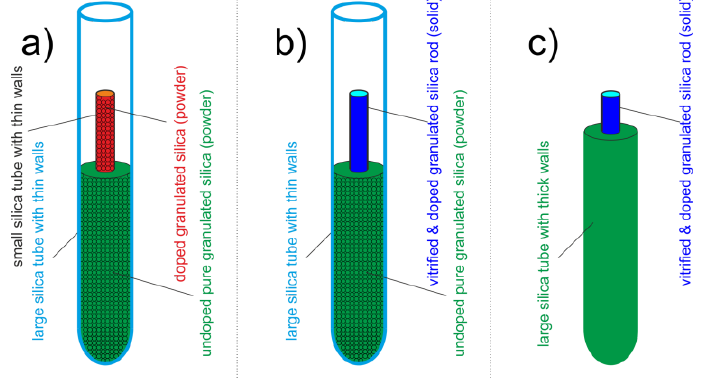
Figure 1. Preform assembly. ( a ) Powder-in-tube technique: smaller silica tube is filled with doped granulated silica and the bigger silica tube is filled with undoped pure granulated silica (SiO 2 ). Adapted powder-in-tube technique for vitrified core rods where the cladding area of the preform consists of: ( b ) pure silica granulate (SiO 2 ); or ( c ) solid pure silica [7].